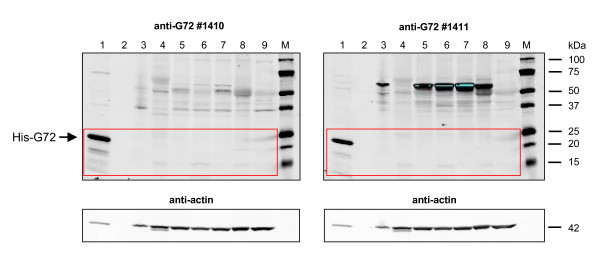
Attempted detection of G72 protein in human samples by western blotting. Western blot membranes were probed with anti-G72 #1410 and #1411 as indicated above and visualised using the LI-COR Odyssey® Infrared Imaging System. Lane 1: total protein lysate from His-G72-transfected HEK-293 cells (positive control). 2: no sample. 3–8: Clontech/BD Biosciences human "protein medleys"; 3: spinal cord. 4: testis. 5: amygdala. 6: cerebellum. 7: frontal lobe. 8: fetal brain. 9: total protein lysate from rat cortex, postnatal day 14 (negative control – no G72 gene in rat). M: molecular weight standards. No specific signal at the expected size of ~18 kDa was detected in any of the human samples. A very weak signal at ~15 kDa was seen in testis, cerebellum and fetal brain (lanes 4, 6, 8). Anti-G72 #1411 detected a strong unspecific signal of unknown identity in all human CNS samples (lanes 3, 5, 6, 7, 8). Blots were reprobed with anti-actin as a loading control (lower panel).